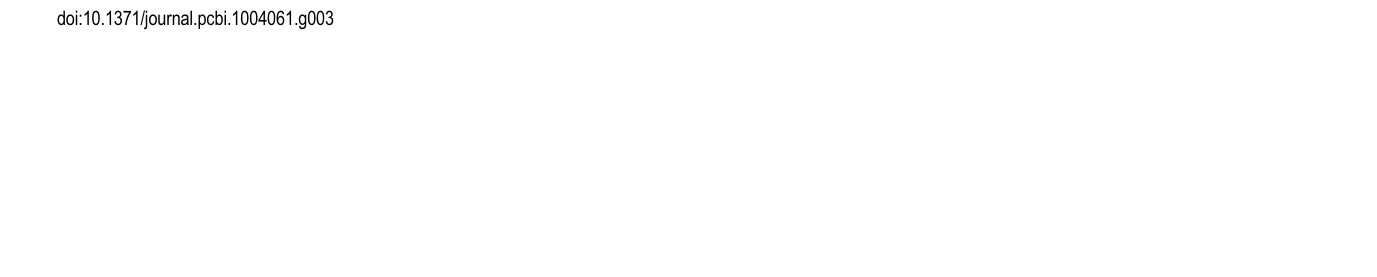
PLOS Computational Biology | DOI:10.1371/journal.pcbi.1004061 April 7,